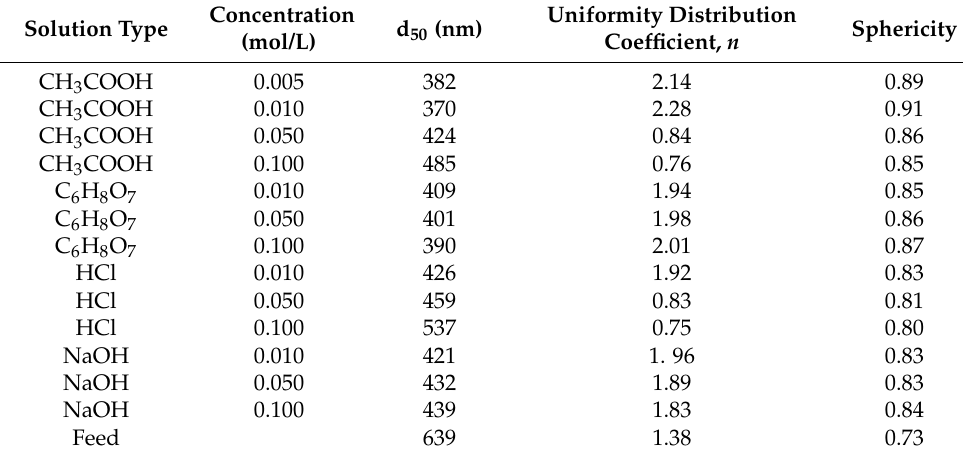
Table 3. The d 50 , n and sphericity values of ZnO particles ground for 30 min in the solutions of CH 3 COOH, C 6 H 8 O 7 , HCl and NaOH at different concentrations.